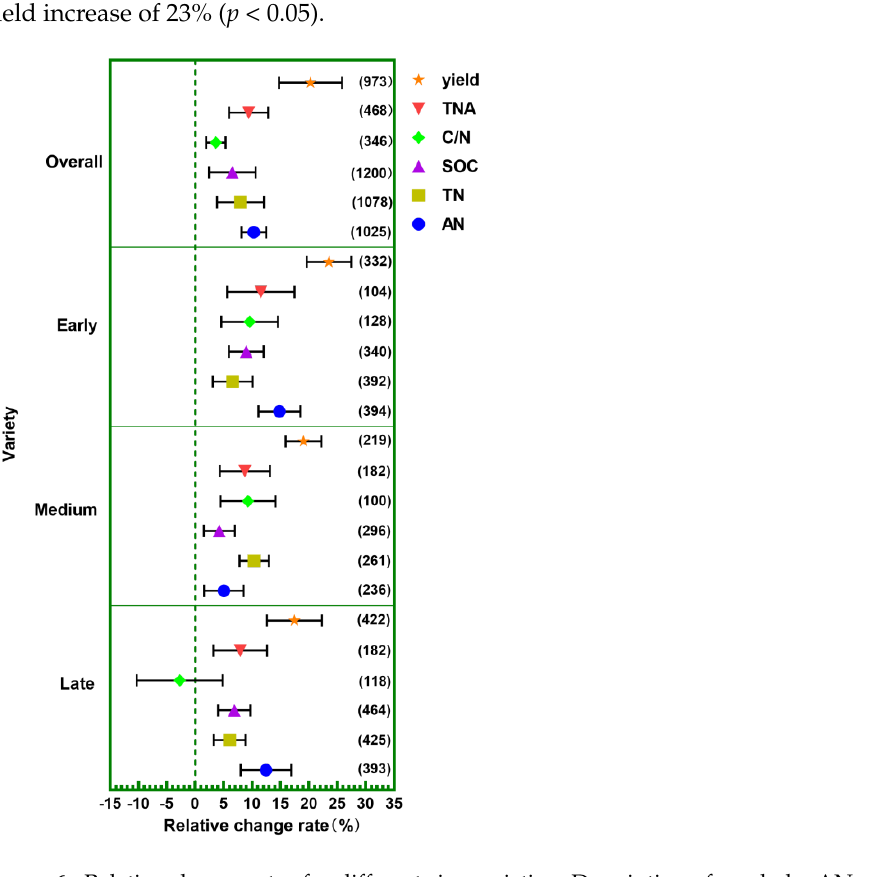
Figure 6. Relative change rates for different rice varieties. Description of symbols: AN, soil alkali-hydrolysable nitrogen; TN, soil total nitrogen; SOC, soil organic matter; C:N, the soil carbon-nitrogen ratio. Numbers in parentheses represent the effect value (lnR).